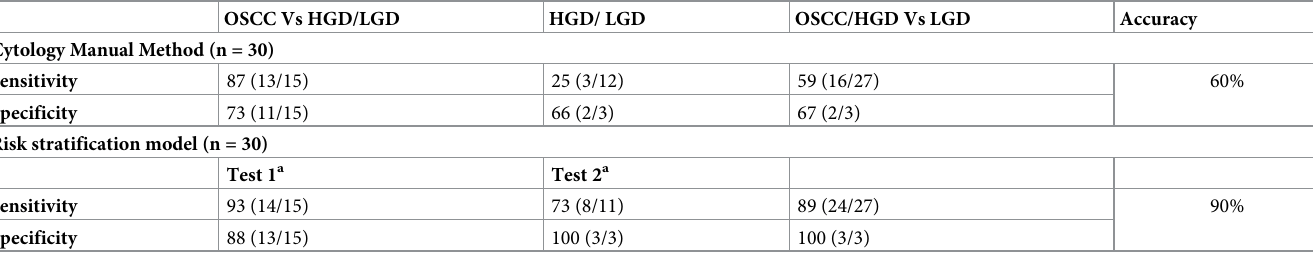
Table 2. Sensitivity and specificity of manual cytology method and risk stratification